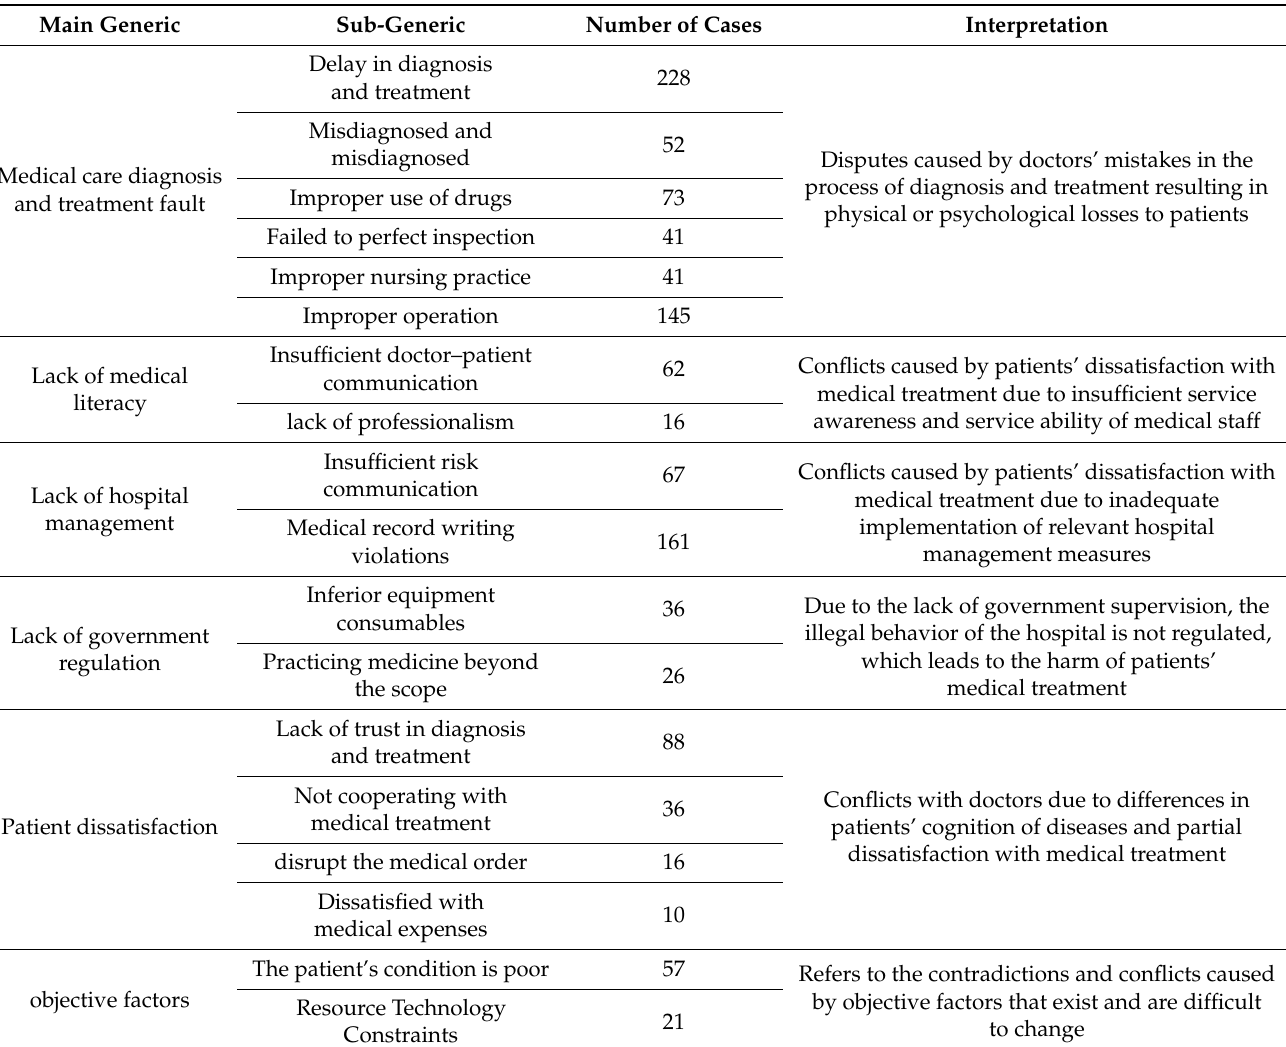
Table 3. Summary of main axis